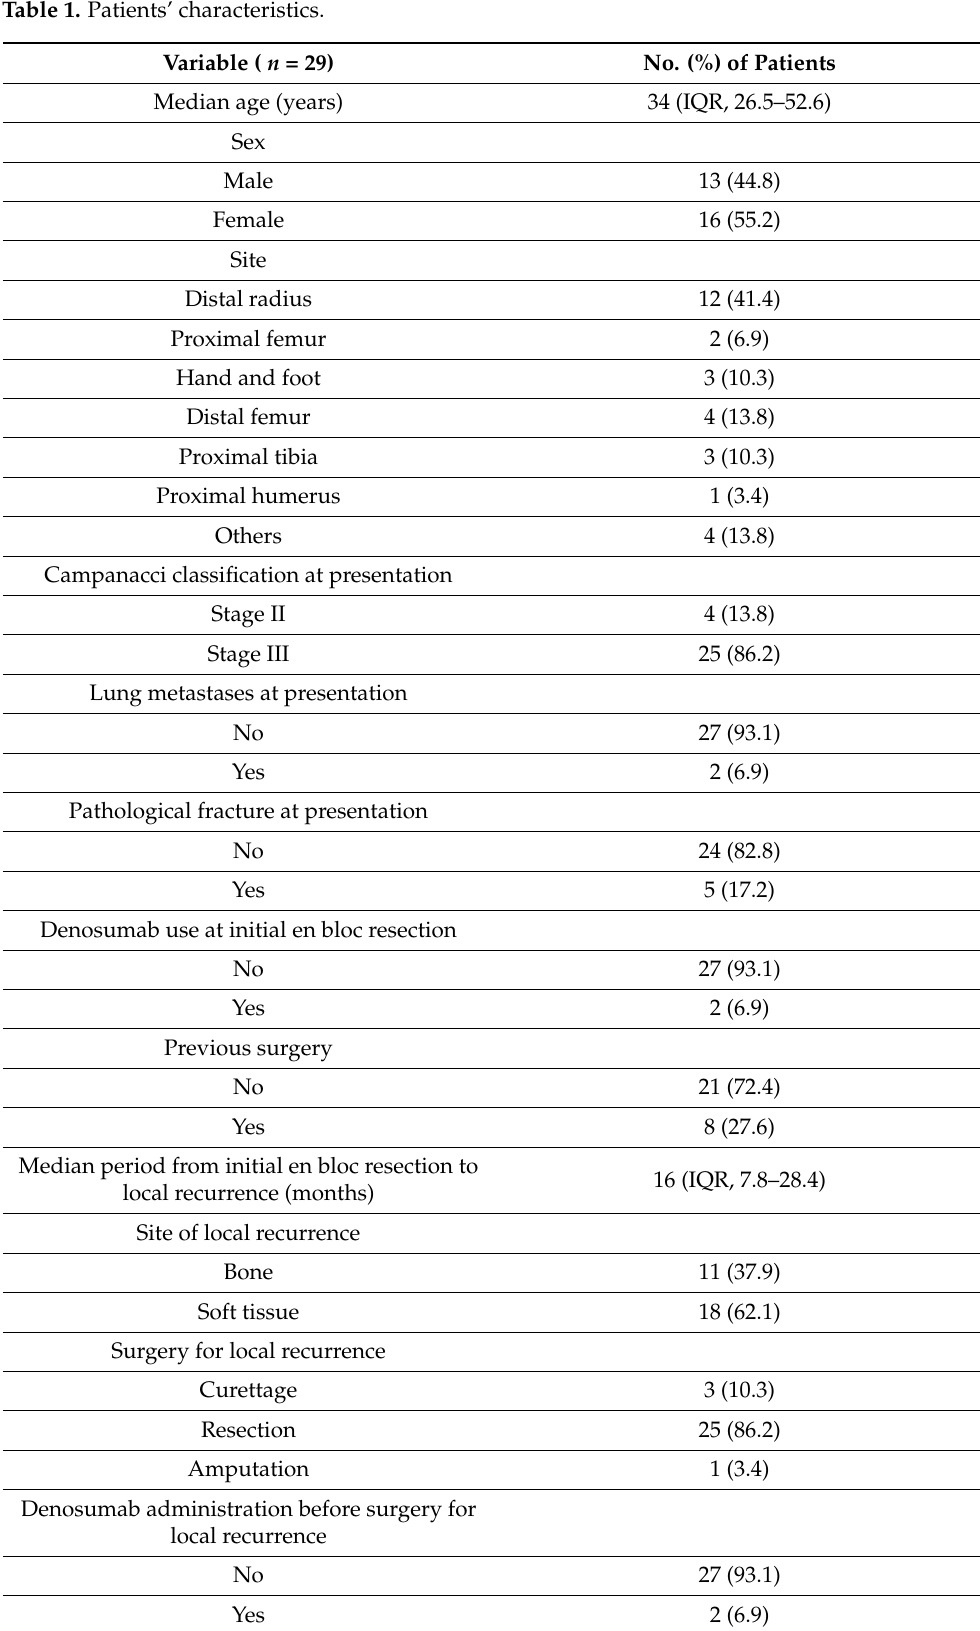
Table 1. Patients’